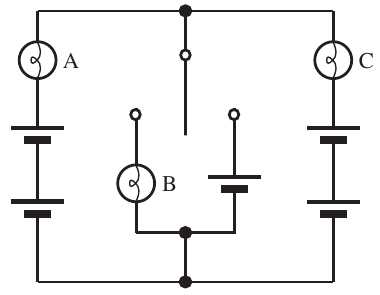
FIG. 11. Circuit diagram used in a multiple batteries in mul- tiple